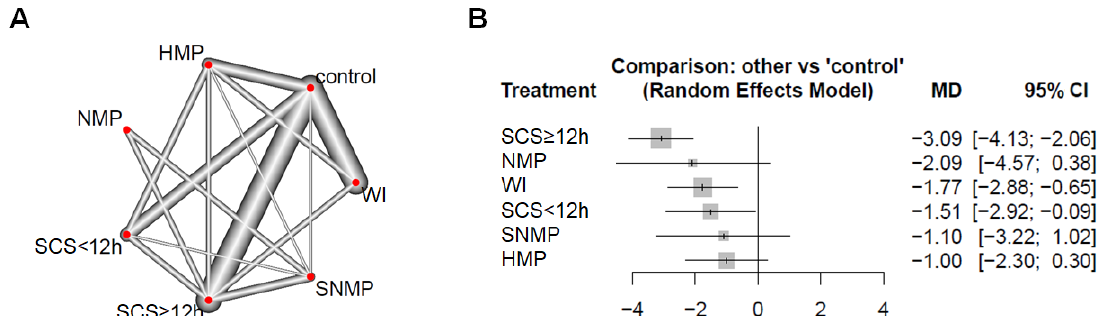
Figure 5. Comparison of tissue ATP content. ( A ) Networks of all preservation and control groups in included studies. The width of the lines is proportional to the number of direct comparisons. ( B ) Forest plot of mean differences (MD) compared to control group. For all comparisons, the random effect analysis was used. SCS ≥ 12 h: static cold storage for over 12 h; SCS < 12 h: static cold storage for less than 12 h; WI: warm ischemia; HMP: hypothermic machine perfusion; NMP: nor-